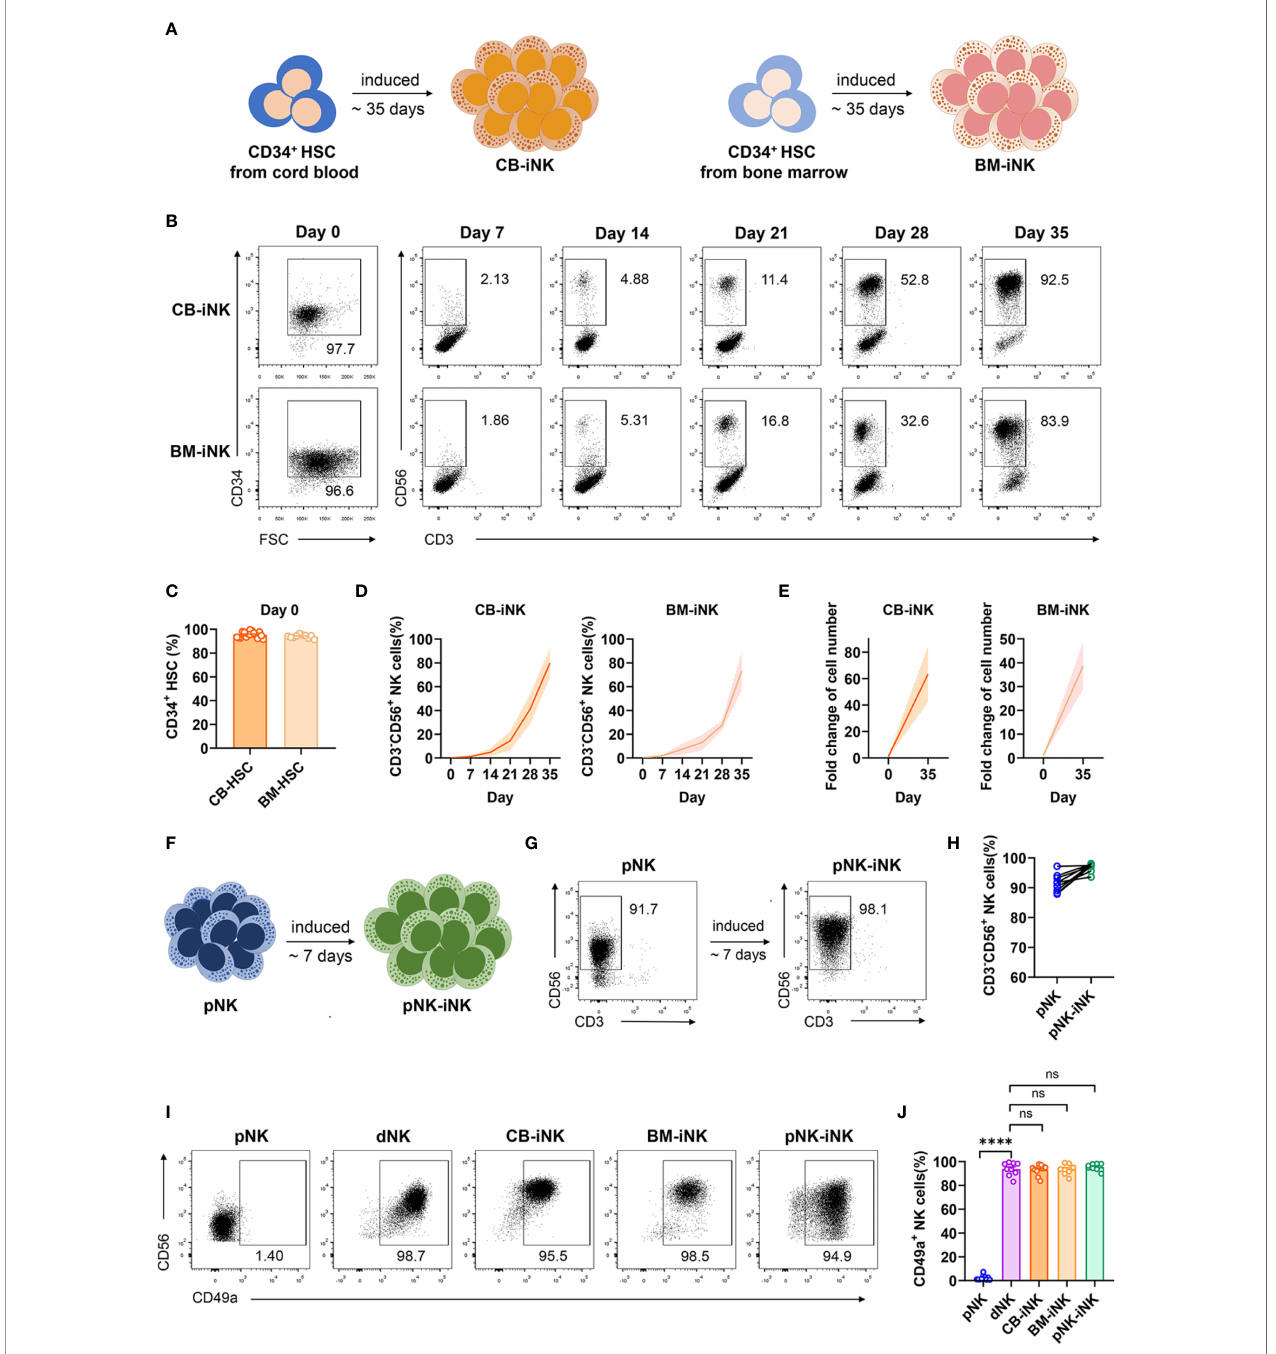
FIGURE 1 | Inducing human CD49a + NK cells from three different sources. (A) Schematic diagram of CB-iNK cells (left) and BM-iNK cells (right) acquired from HSCs. (B) Representative density plots of CD34 + cells sorted from cord blood or bone marrow mononuclear cells, and fl ow cytometric analysis of the percentage of CD3 - CD56 + NK cells in the system on days seven through thirty- fi ve. (C) Statistical analysis of CD34 + HSCs purity after MACS sorting. (D, E) Flow cytometry analysis of frequency (D) and absolute number (E) for CD3 - CD56 + NK cells on day 35 of culture. (F) Schematic diagram of pNK-iNK cells acquired from puri fi ed pNK cells. (G) Representative density plots of CD3 - CD56 + pNK cells and pNK-iNK cells. (H) Statistical analysis of CD3 - CD56 + NK cells. (I, J) The percentage of CD3 - CD56 + NK cells that expressed CD49a in each group was tested by fl ow cytometry. Representative density plots (I) and statistical calculation of all samples (J) . Data was analyzed by one-way ANOVA. Data represent means± SD, n ≥ 6 in each group. ****p < 0.0001; ns, not signi fi